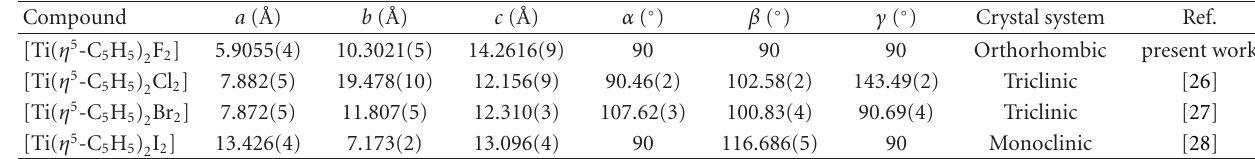
Table 4: Comparison of unit cell parameters for the four prototype titanocene dihalogenides, [Ti( η 5 -C 5 H 5 ) 2 X 2 ].